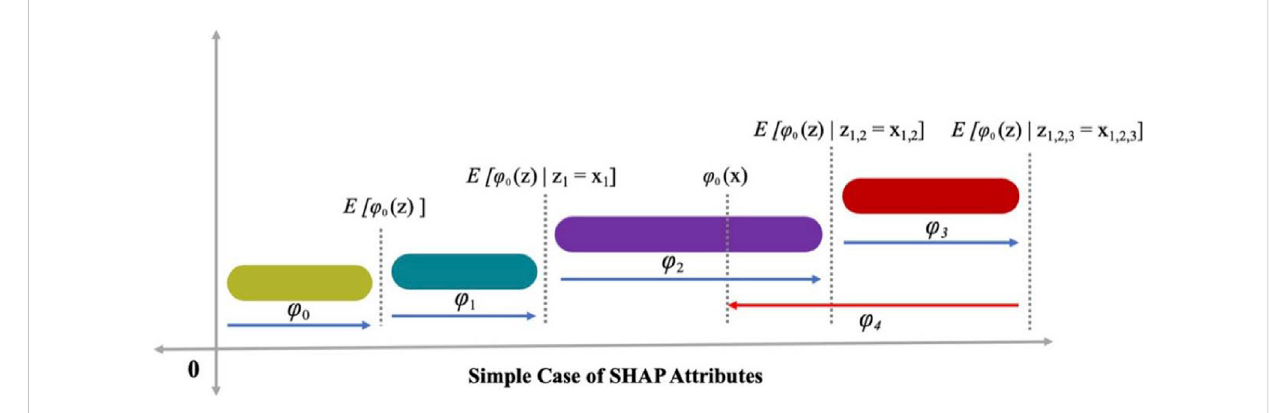
FIGURE 5 Attributes of SHAP (Shen et al.,